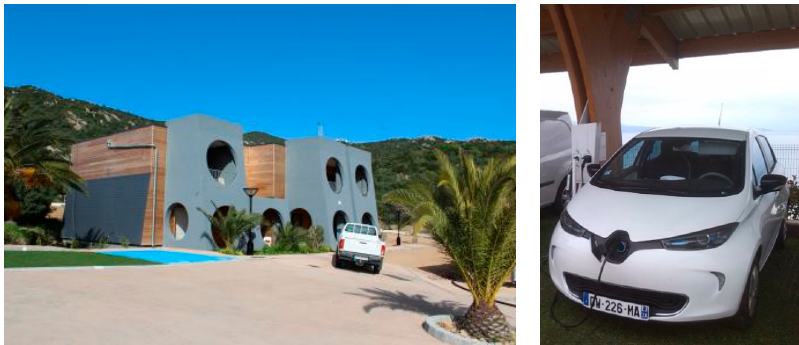
Figure 2. Energy Storage systems (ES): Batteries and inverters/chargers.